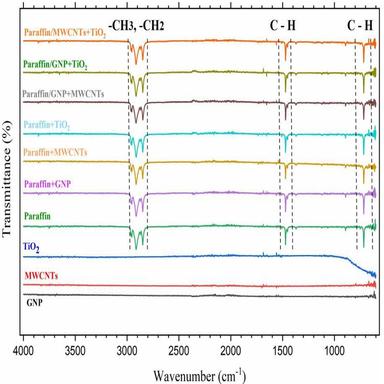
FT-IR spectra of different samples.